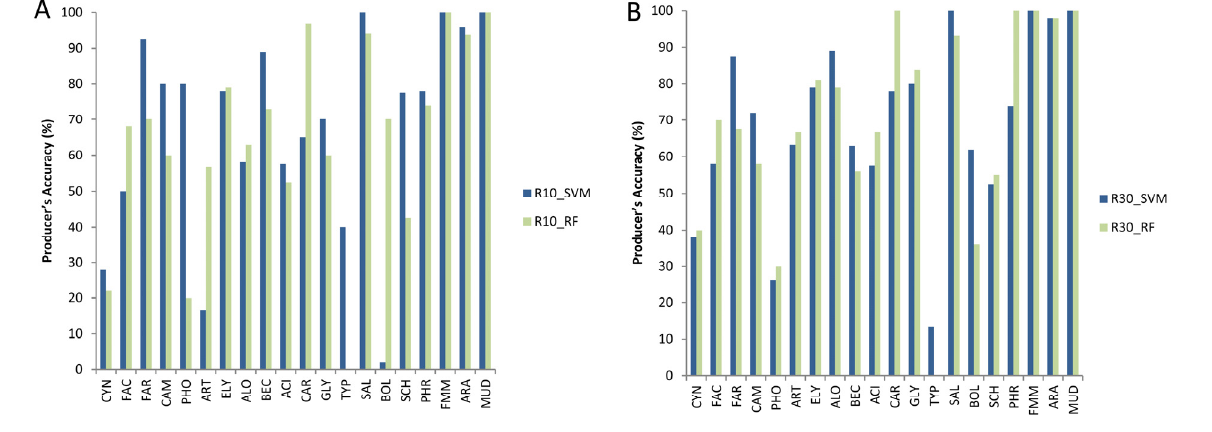
Figure 5. Producer’s accuracy (%) of the classes of SVM and RF classifiers using original bands and 10 ( A ) and 30 ( B ) random training